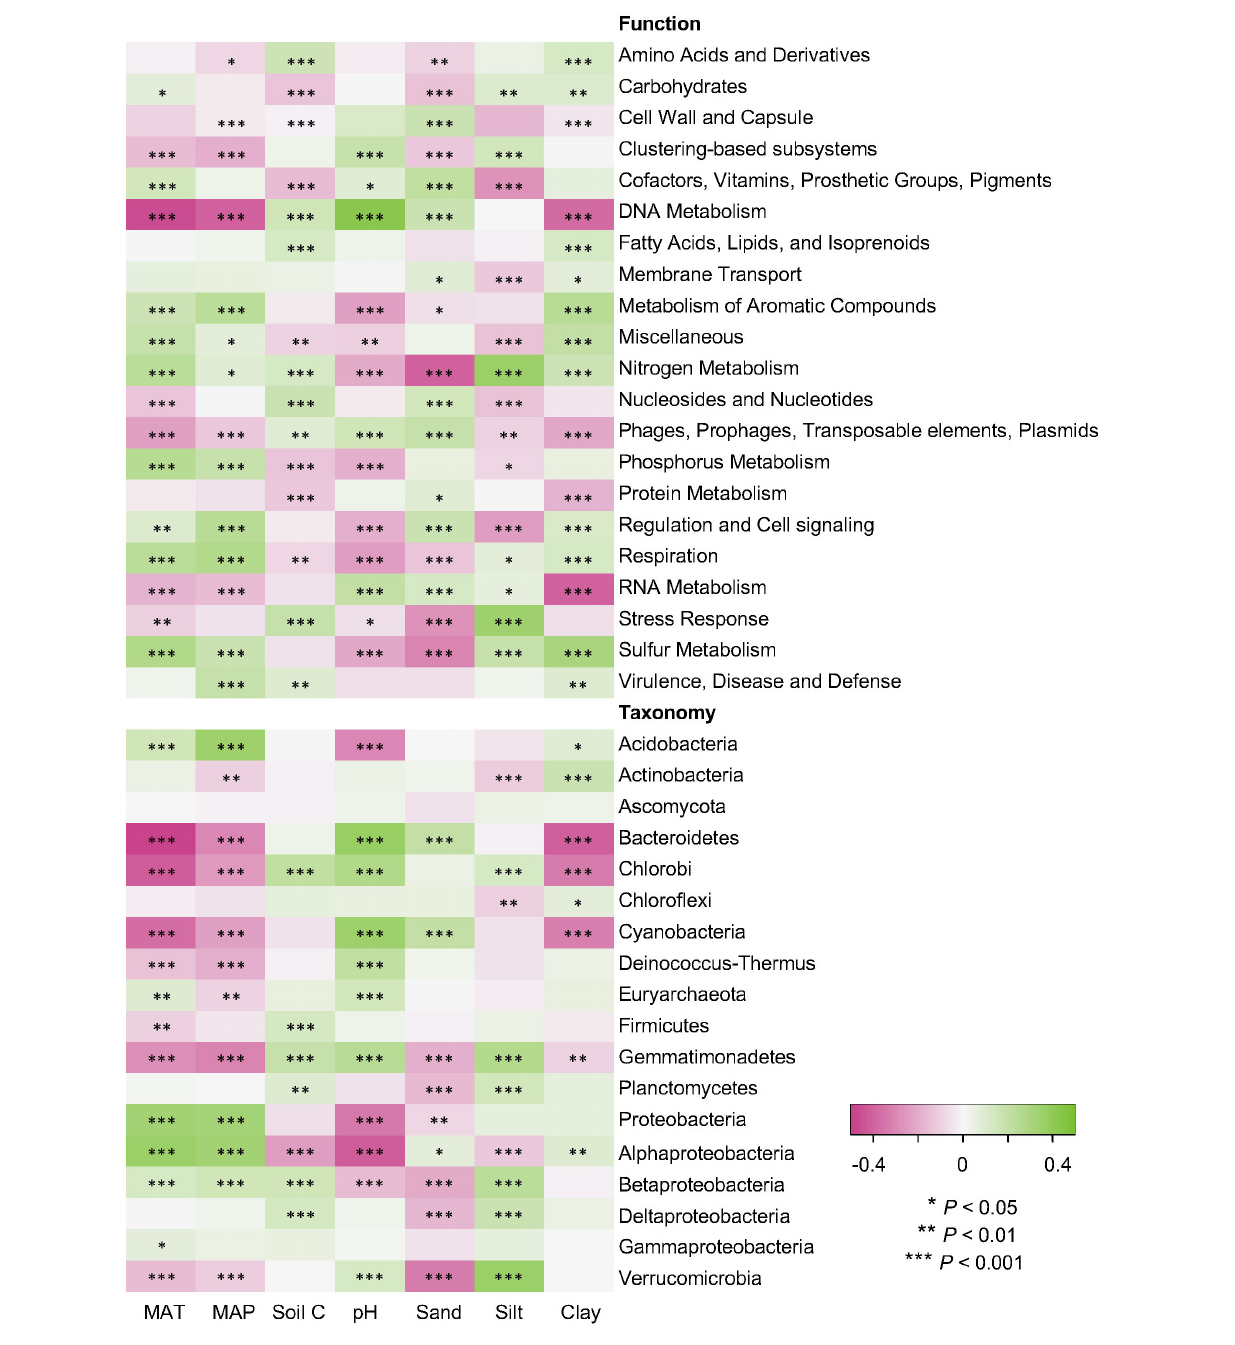
compositions are all cooperative (Faust and Raes,